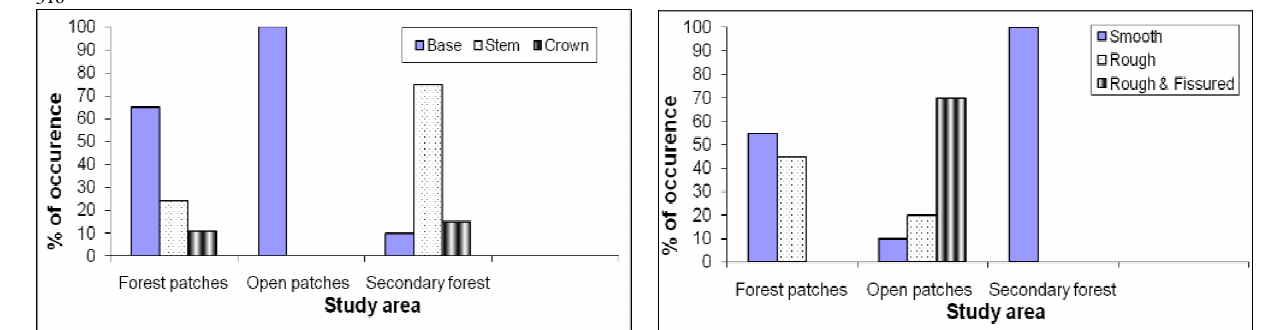
Fig. 2. Distribution of epiphytes on different point on the host species across the study sites at Obafemi Awolowo University, Ile-Ife